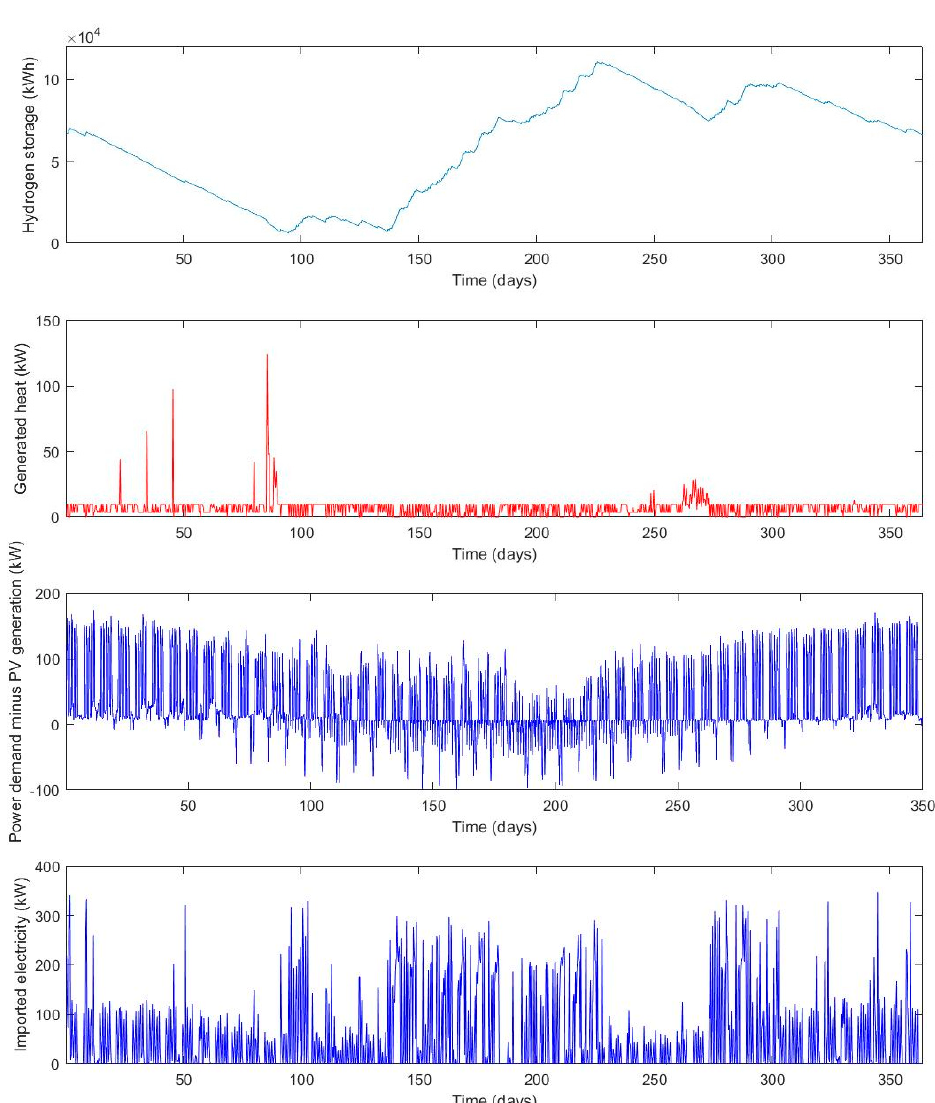
/ 200 kW RSOC system with 1000 m 2 solar PV Figure A4. Optimal operation of a 50/200 kW RSOC system with 1000 m 2 solar PV panel. Figure A4. Optimal operation of a 50